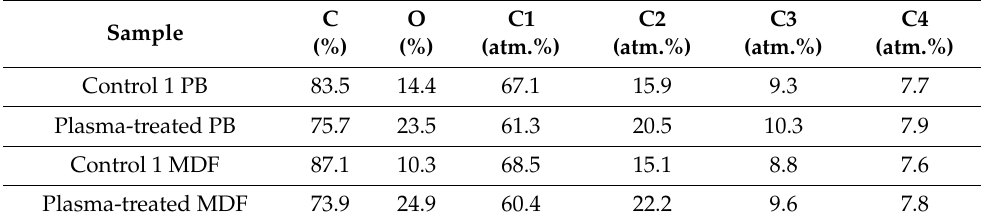
Figure 3. High-resolution spectra of ( a ) Control 1 PB, ( b ) Control 1MDF, ( c ) plasma-treated PB, and ( d ) plasma-treated MDF. Table 3. Relative surface composition of untreated and plasma-treated PB and MDF.